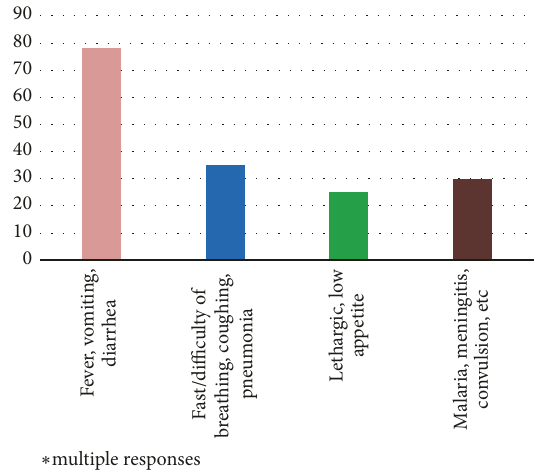
Figure 2: Danger signs of infancy reported by the caregivers. Most of the caregivers identified fever, vomiting, and diarrhea as the common danger signs of infancy.